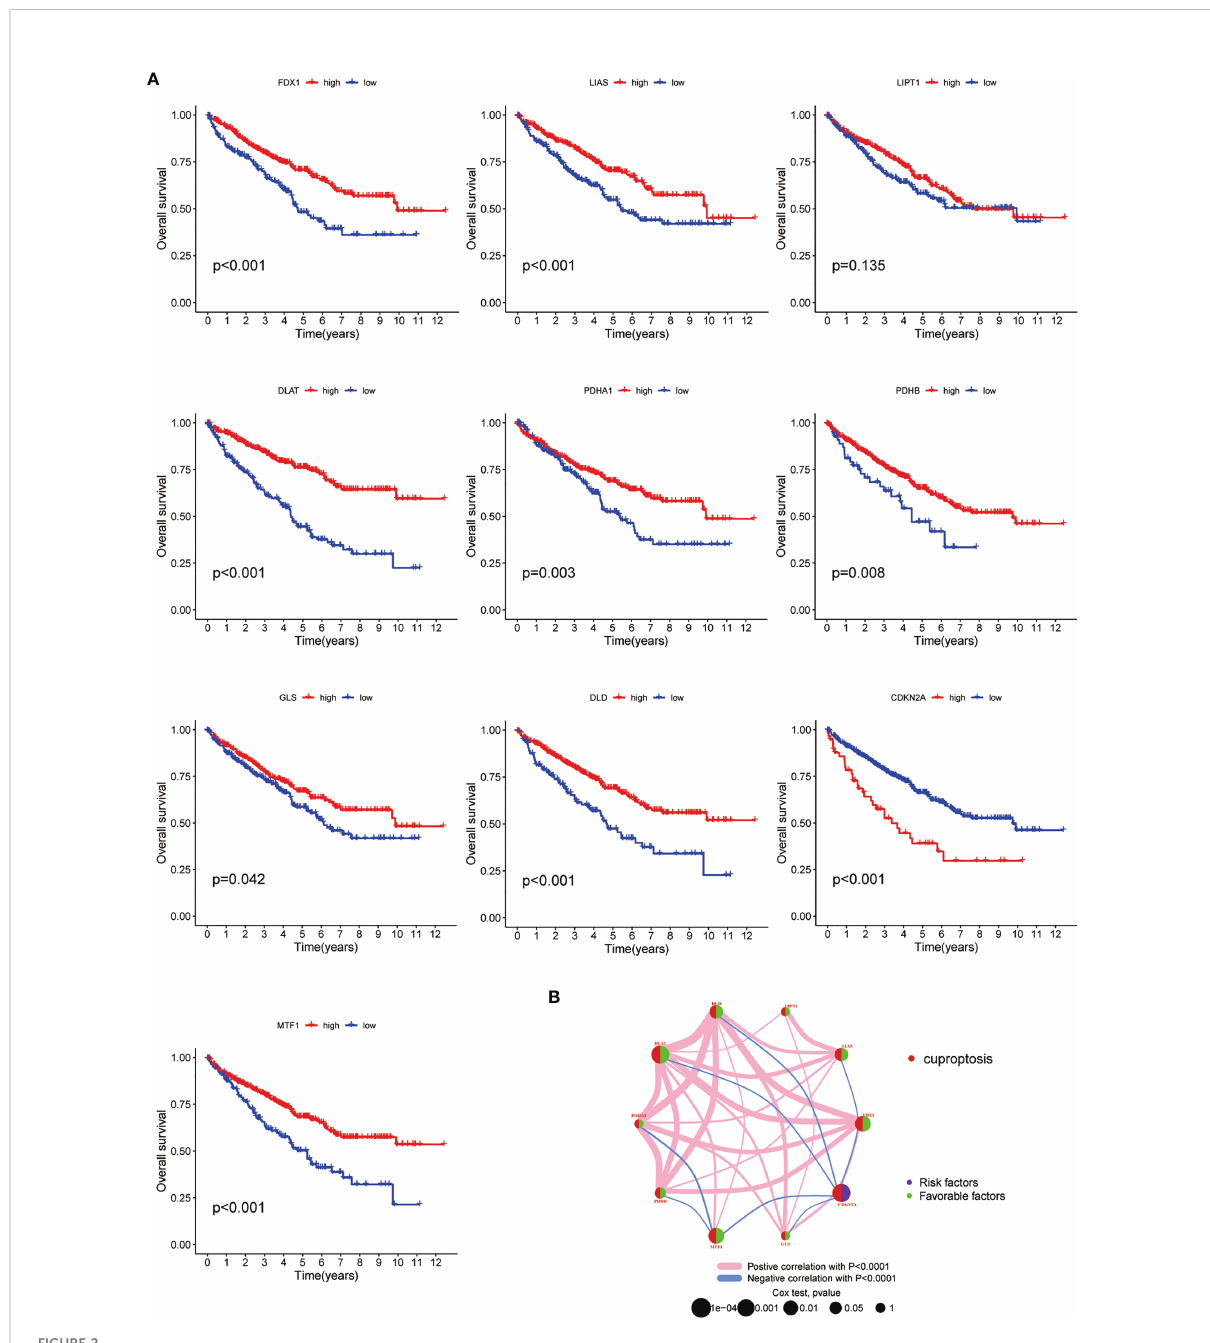
FIGURE 2 Survival correlation of CAGs in ccRCC patients. (A) Kaplan – Meier survival curves of 10 CAGs. (B) Interactive plot of 10 CAGs in the ccRCC cohort. The signi fi cance was labeled in different colors and sizes of dots ( p < 0.05 *; p < 0.01 **; p < 0.001 ***. NS, not signi fi cant). CAGs: cuproptosis-associated